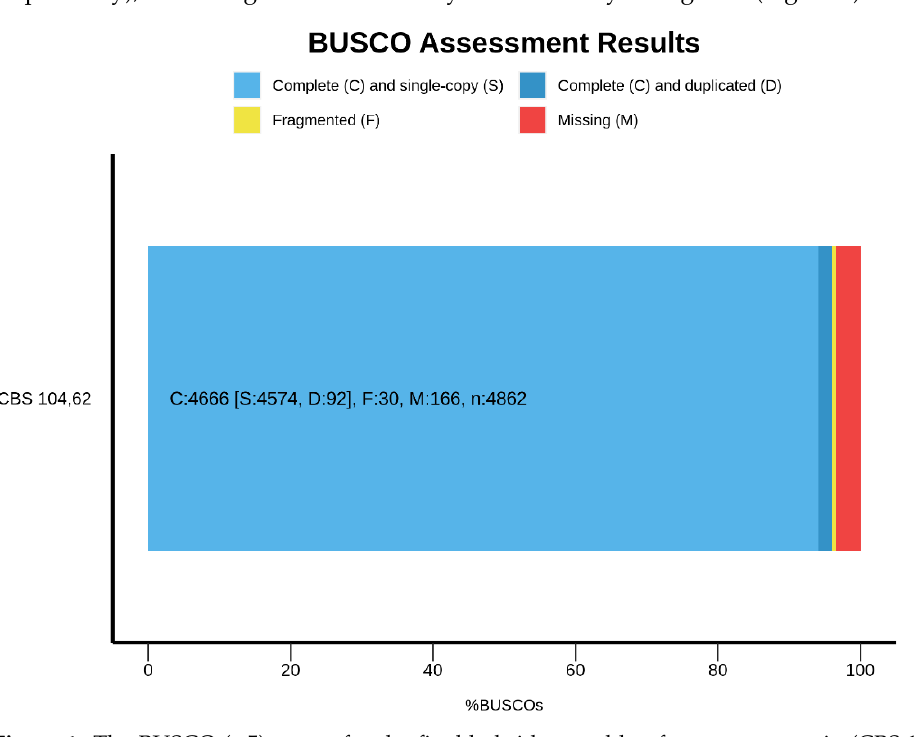
Figure 1. The BUSCO (v.5) report for the final hybrid assembly of an ex-type strain (CBS 104.62) of Chrysosporium keratinophilum genome. The light blue portion of the bar represents complete (C) and single-copy (S) orthologs, dark blue represents complete and duplicated (D) orthologs, yellow represents fragmented (F) BUSCO genes and red represents missing (M) BUSCO genes.